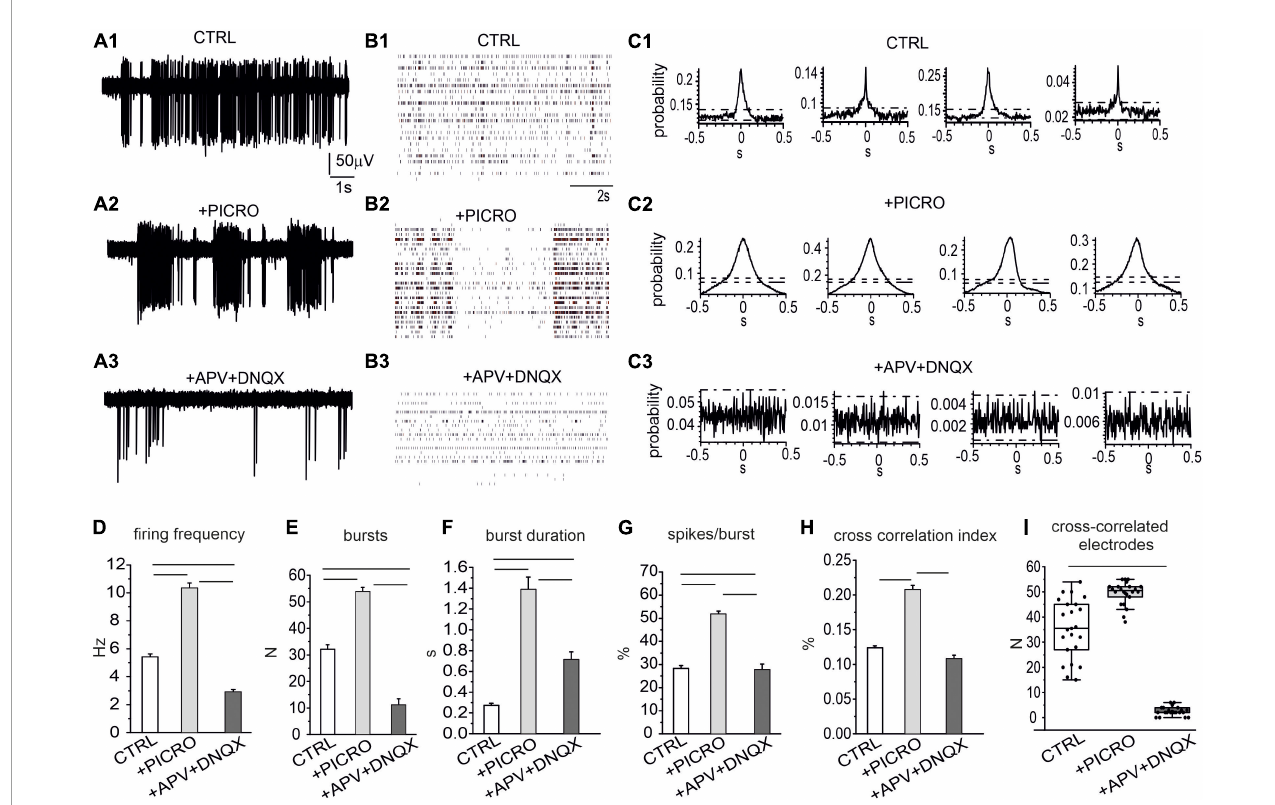
FIGURE4 Role of excitatory and inhibitory neurons in regulating the spontaneous activity of the network. (A1–A3) Representative traces under control conditions, after addition of picrotoxin (100 µ M) and of APV (50 µ M) plus DNQX (20 µ M), to selectively block GABA A , NMDA and AMPA/kainate receptors. (B1–B3) Raster plots in the three experimental conditions (control, + picrotoxin, + APV and DNQX). (C1–C3) Representative cross-correlograms (CCH) in control conditions, after the addition of picrotoxin and after the addition of APV and DNQX. (D) Mean firing rate in the three conditions (ctrl vs. picro p < 0.0001; picro vs. APV + DNQX p < 0.0001; ctrl vs. APV + DNQX, p < 0.0001). (E) Mean number of bursts during 120 s recordings (ctrl vs. picro, p < 0.0001; picro vs. APV + DNQX, p < 0.0001, ctrl vs. APV + DNQX, p < 0.0001). (F) Mean burst duration (ctrl vs. picro, p < 0.0001; picro vs. APV + DNQX, p < 0.0001; ctrl vs. APV + DNQX, p < 0.0001). (G) Percentage of bursts during 120 s recordings (ctrl vs. picro p < 0.0001, picro vs. APV + DNQX, p < 0.0001, ctrl vs. APV + DNQX, p = 0.0028). (H) Cross-correlation index (evaluated as the mean peak amplitude of the cross-correlogram, see C for the representative examples) (ctrl vs. picro p < 0.0001, picro vs. APV + DNQX, p < 0.0001). (I) Box-plot histogram showing the number of cross-correlated electrodes in control condition (CTRL) and after the sequential addition of receptor antagonists (picro, APV + DNQX), (ctrl vs. APV + DNQX, p <